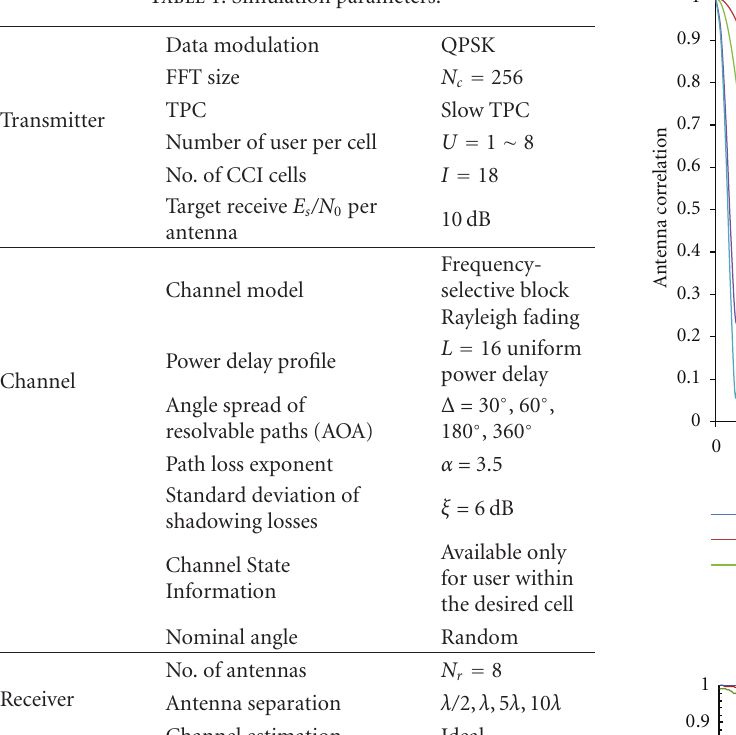
Table 1: Simulation parameters.